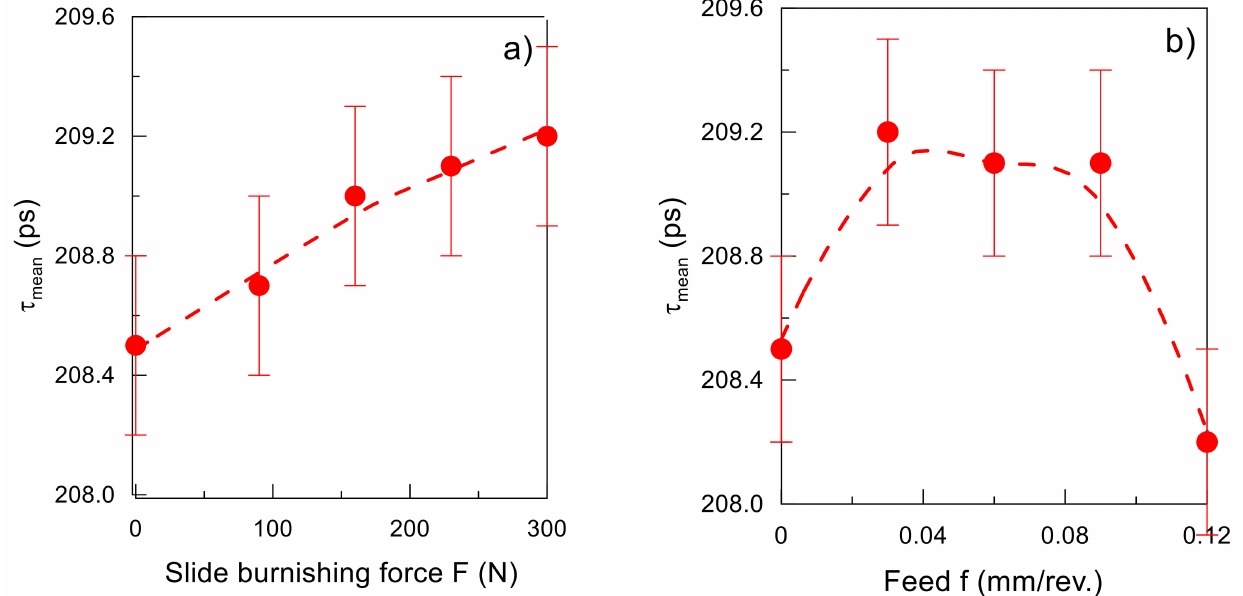
Figure 16. Mean positron lifetime τ mean as a function of ( a ) burnishing force F ( f = 0.06 mm/rev., v n = 35 m/min, i = 1), ( b ) burnishing feed f ( F = 230 N, v n = 35 m/min, i = 1). The dashed lines are only an